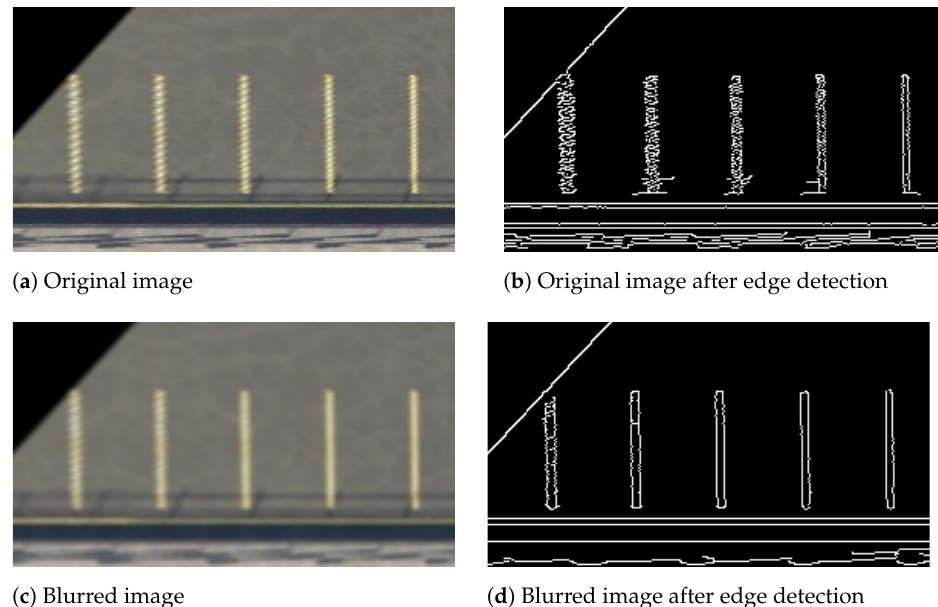
Figure 10. Illustration of an example of a downsampled image and its result after edge detection. ( a , b ) show the image and the result for the original image. ( c , d ) show the image and the result for the blurred